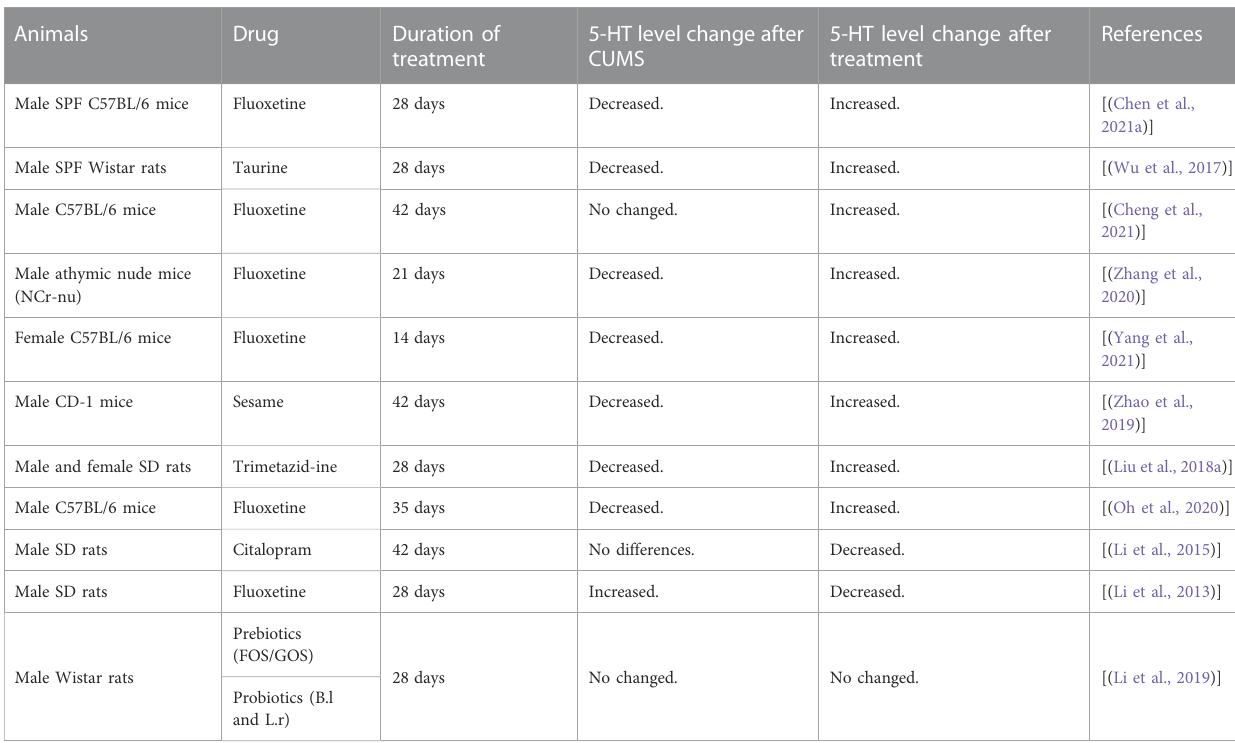
TABLE 3 Evidence of peripheral 5-HT level in CUMS-induced depressive-like behavior animal model. Animals Drug Duration of